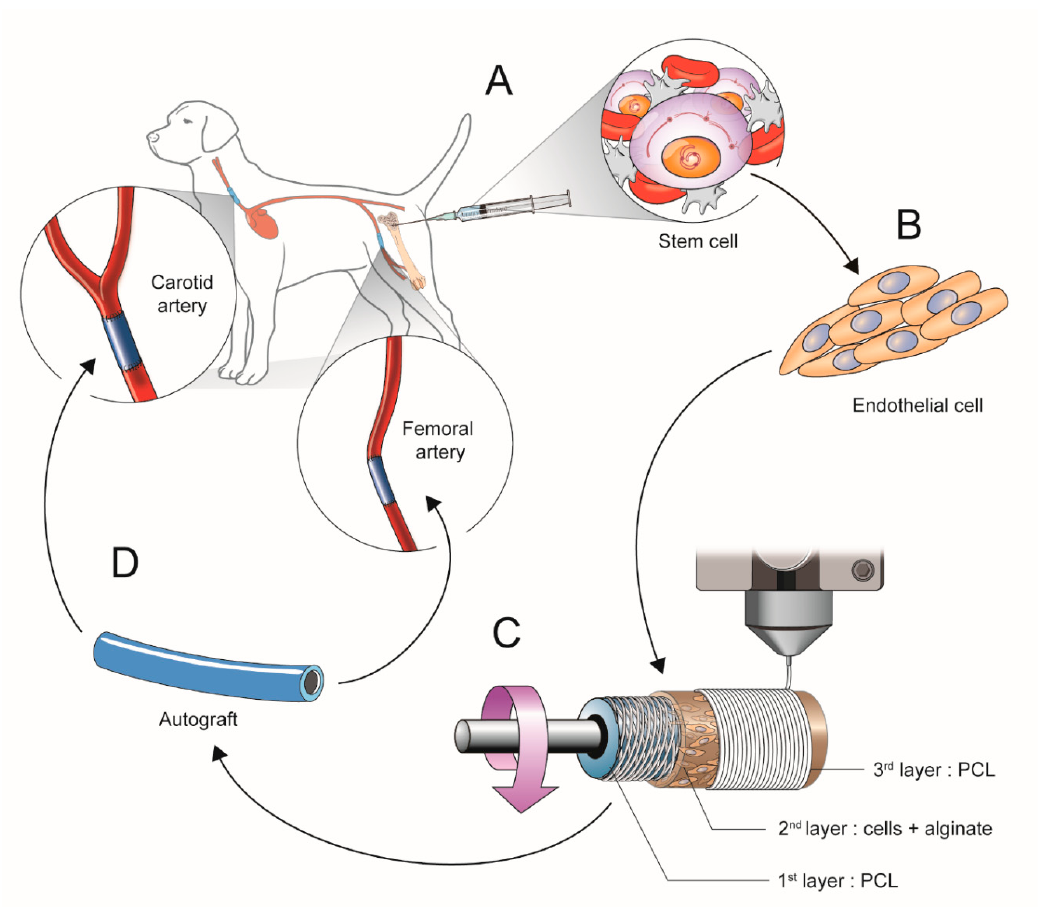
Figure 1. Scheme of the experimental study design. ( A ) The MSCs were cultured from bone marrow of canine femurs. ( B ) Cells resembling endothelial cells were differentiated for 7days. ( C ) The vascular scaffold was constructed with 3-layers (1st: PCL, 2nd: cells and alginate, 3rd: PCL) by 3D bio printing. ( D ) The vascular scaffold was implanted into the bilateral carotid arteries and femoral arteries of canines.